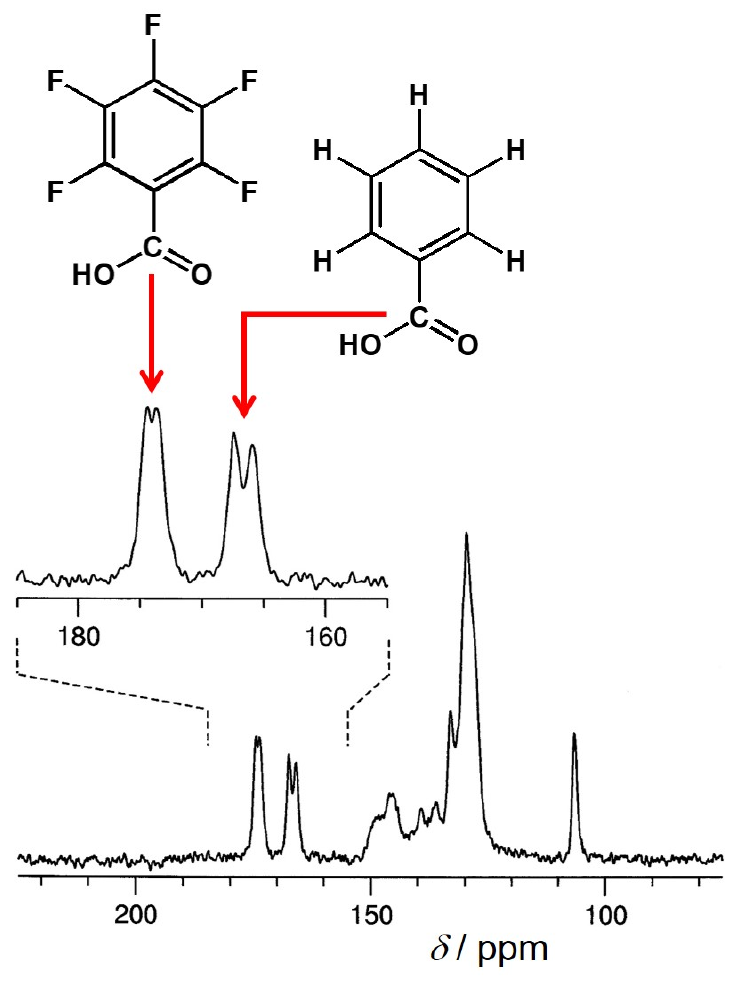
Figure 3. Experimental high-resolution solid-state 13 C NMR data for the 1:1 co-crystal of benzoic acid and pentafluorobenzoic acid. The two peaks at ca. 167 ppm are due to the carboxylic acid group of benzoic acid. The two peaks at ca. 174 ppm are due to the carboxylic acid group of pentafluorobenzoic